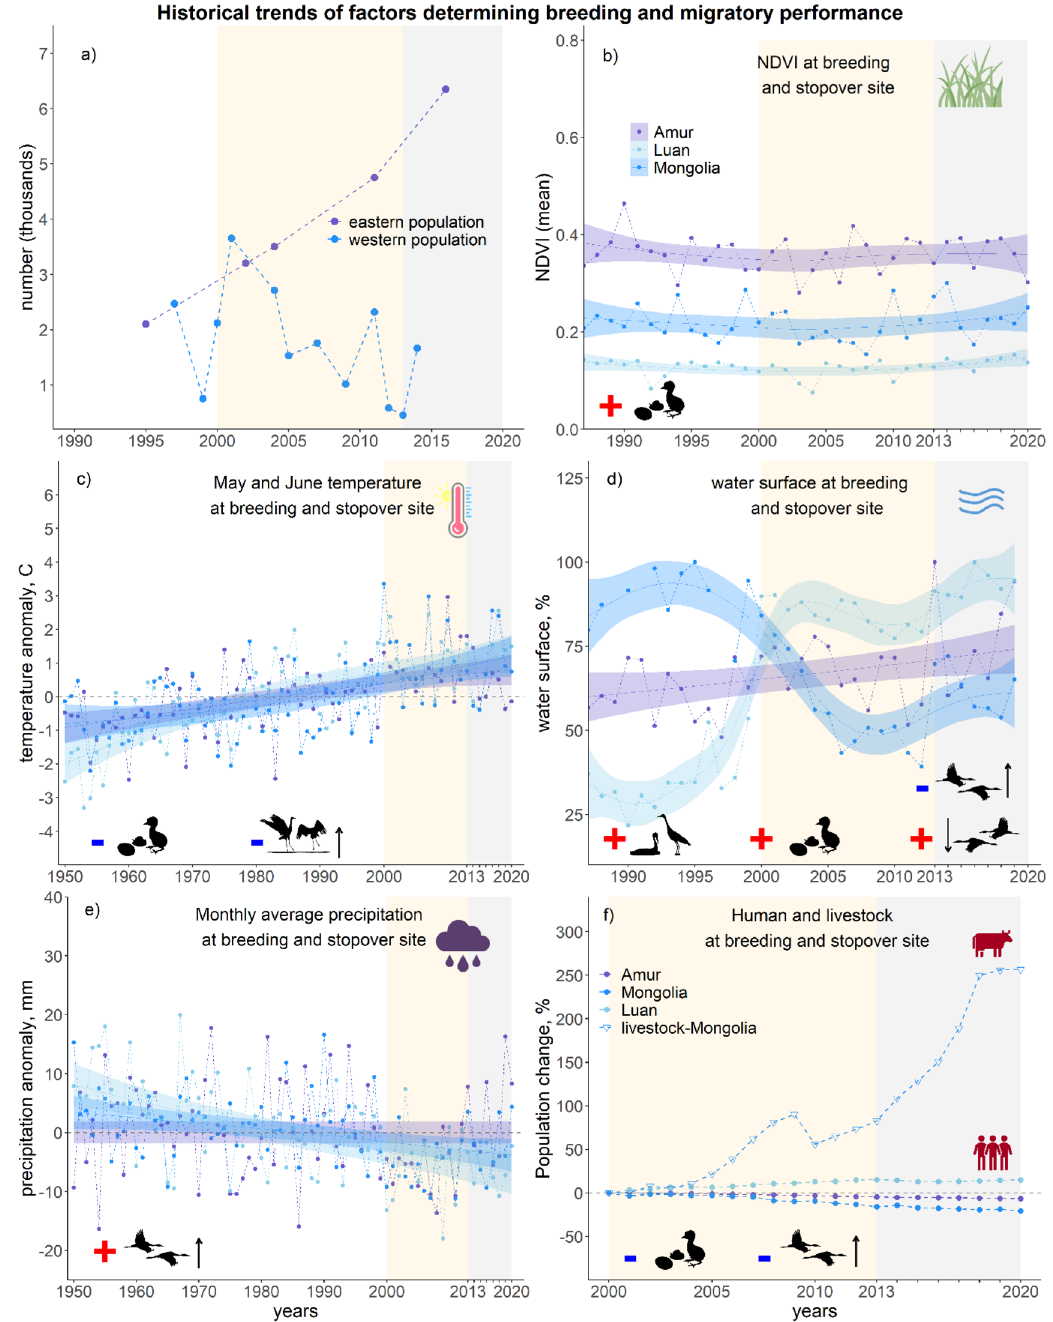
Figure 5. Historical trends of WNC populations and environmental factors potentially affecting breeding and migratory performance. Population estimates (panel- a ) of western population were obtained from Wang, Fraser 39 , while estimates of eastern population were obtained from Wetland International’s database. Historical trends of NDVI ( b ), temperature ( c ), water availability ( d ), precipitation ( e ), annual changes in human population density and livestock for both western (blue) and eastern (navy) breeding grounds ( f ), and major migratory stopover site of the western population at Luan (light blue) are also depicted in panel ( b – f ). Grey shading indicates the timeframe for which nest monitoring was conducted. Note that the time axis may differ from panel to panel and that for ease of comparison, the yellow shading indicates a period of major drought at the breeding grounds of Mongolia and Amur. All figures were generated in RStudio v2022.02.2 (http:// www. rstud io. com) 61